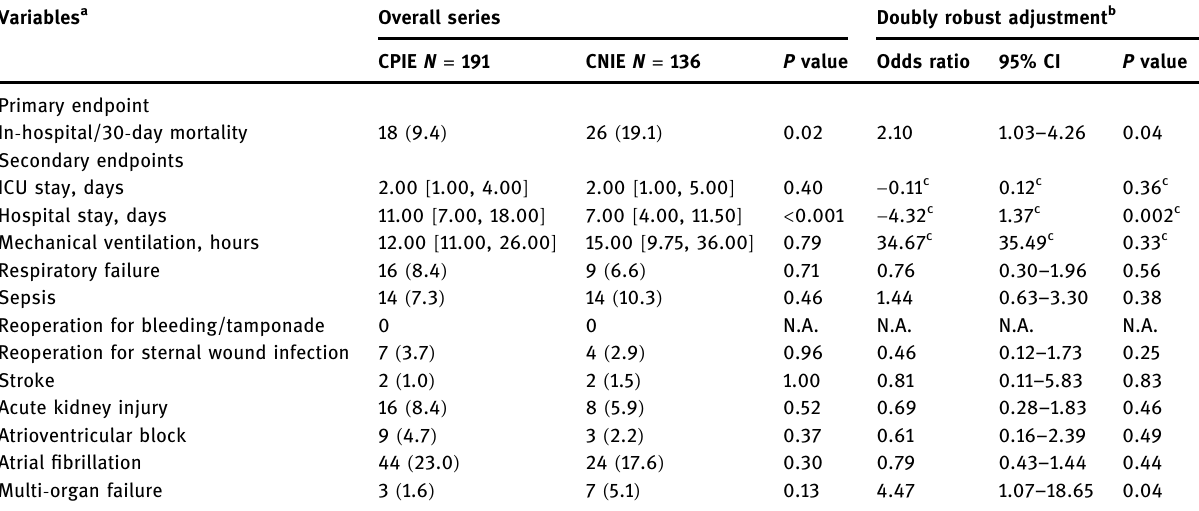
Table 3: Early outcomes between patients with CPIE and CNIE and the doubly robust matching estimators for confounding adjustment Variables a